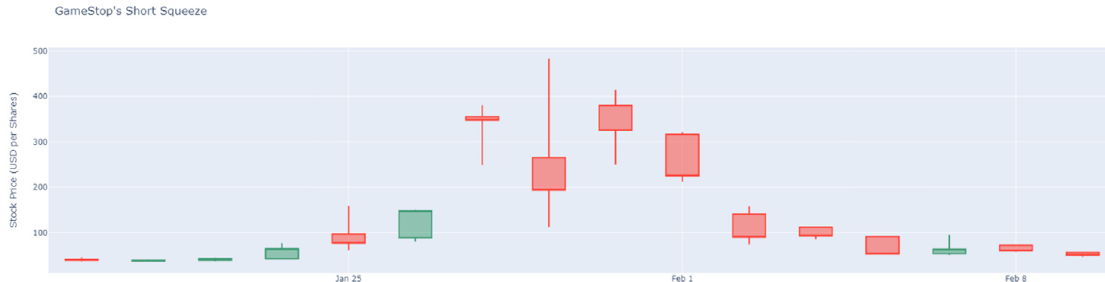
Figure 1. Plot of the GameStop price throughout the short squeeze.